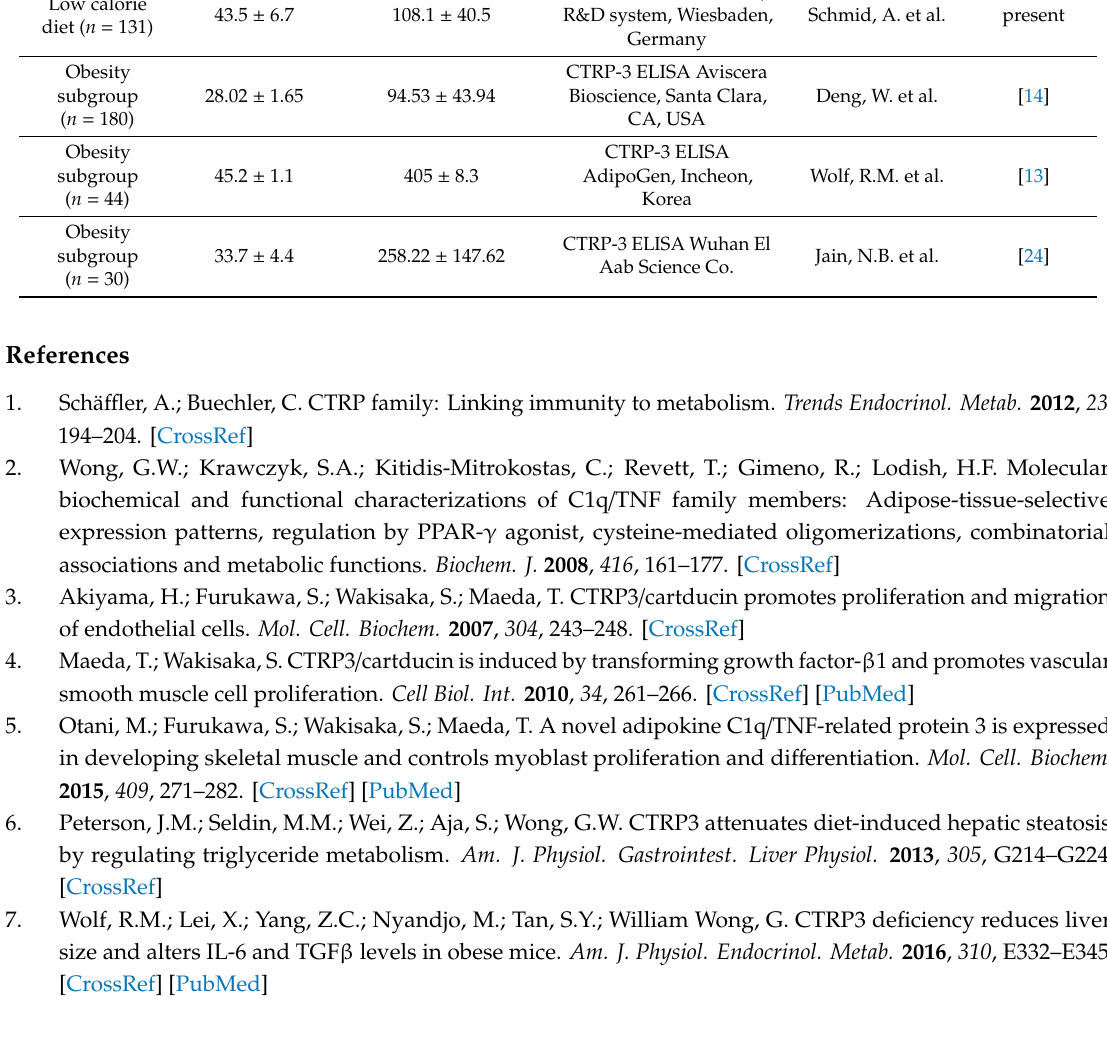
Table A1. Human CTRP-3 serum levels in obesity as measured by di ff erent ELISA kit suppliers. Serum data from the present study (human CTRP-3 ELISA Kit from R&D Systems, Wiesbaden, Germany) are depicted together with data published by Deng et al. ( Diabetol Metab. Syndr. , 2015 [14]; ELISA Kit from Aviscera Bioscience, Santa Clara, CA, USA), Wolf et al. ( PLoS ONE , 2015 [13]; ELISA Kit from AdipoGen, Incheon, Korea), and Jain et al. ( Int. J. Endocrinol. Metab. , 2019 [24]; ELISA Kit from Wuhan EIAab Science Co.). BS, bariatric surgery (present study); LCD, low calorie diet (present study). Mean CTRP-3 Serum Mean BMI Concentrations ELISA Supplier Study Reference Cohort (kg / m 2 ) (ng / ml) Bariatric